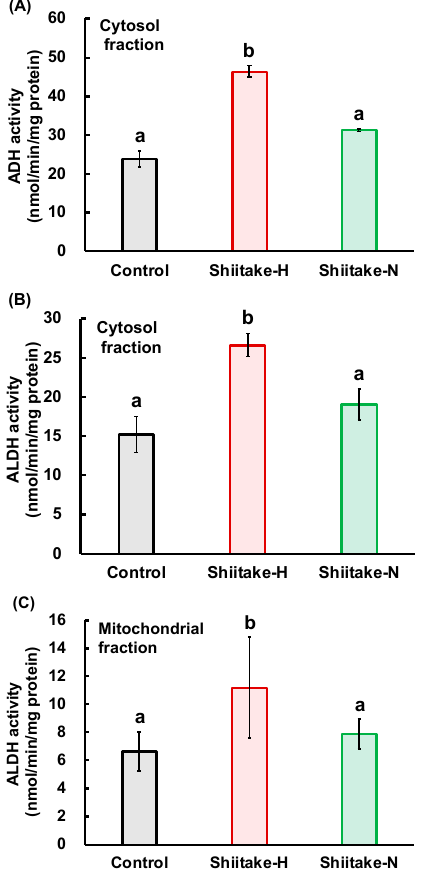
Figure 7. Effect of shiitake extract on ADH and ALDH activities in the stomach. ( A ) ADH activity in cytosol fraction; ( B ) ALDH activity in cytosol fraction; ( C ) ALDH activity in mitochondrial fraction. Results with different letters are significantly different at p < 0.05. Data are the means ± S.D.; n = 6.